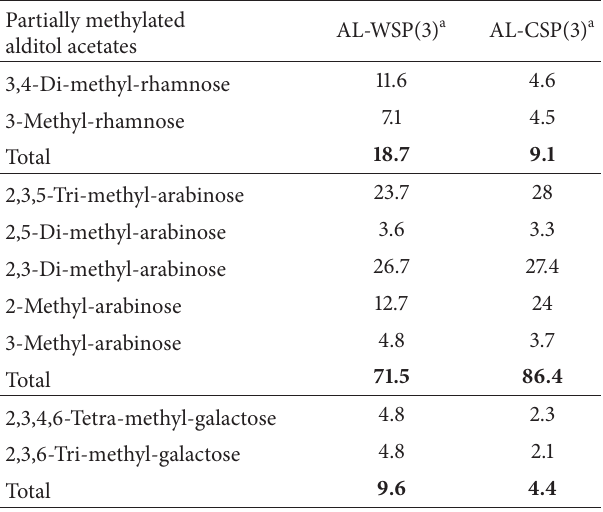
Table 4: Partially methylated alditol acetates ofwater-soluble AL- WSP(3) and chelating-soluble AL-CSP(3) pectins obtained by gas chromatography-mass spectrometer (GC-MS).